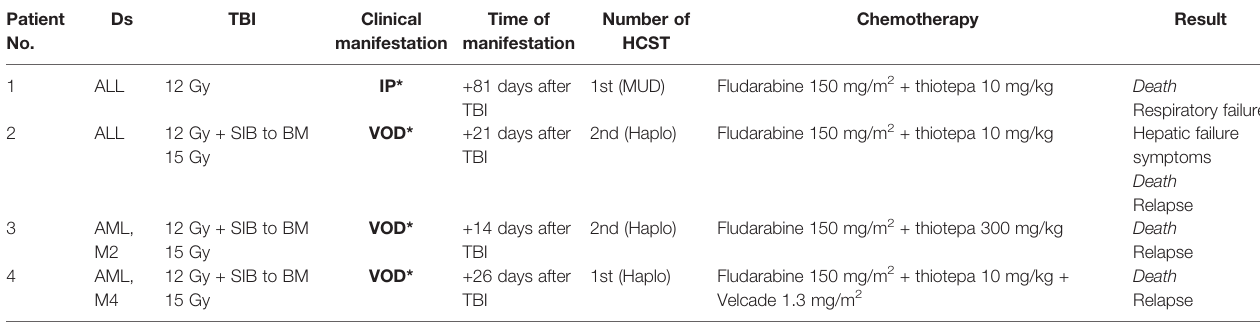
TABLE 5 | Radiation-induced subacute toxicity and causes of death. Patient